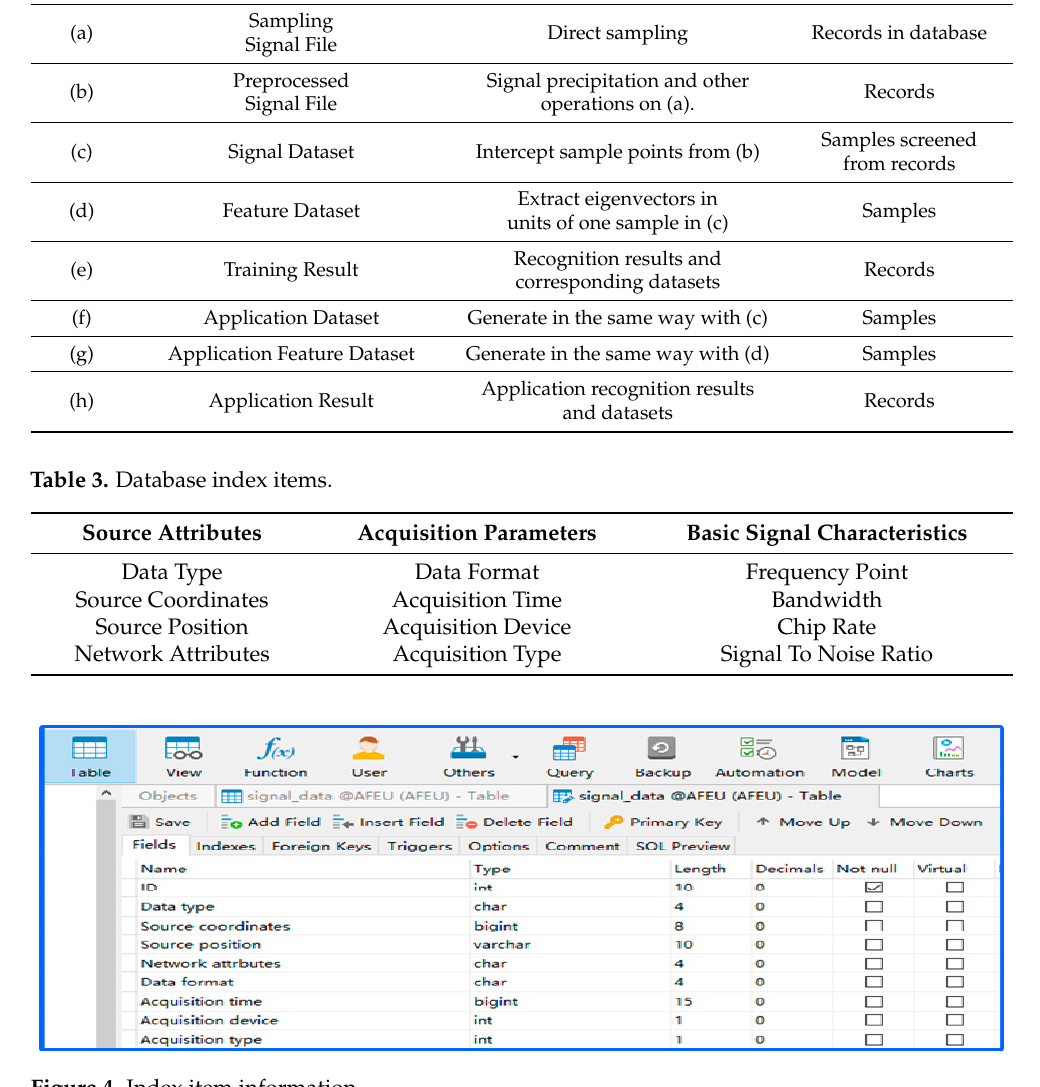
Figure 5. Database framework. We add labels to each data segment to form dataset samples. Multiple fixed-length dataset samples containing different labels are combined to form the dataset for training. The structure of the datasets exported from the database is shown in Figure 6 and are used for verifying the performance of our methods I-channel of the sampling data 1